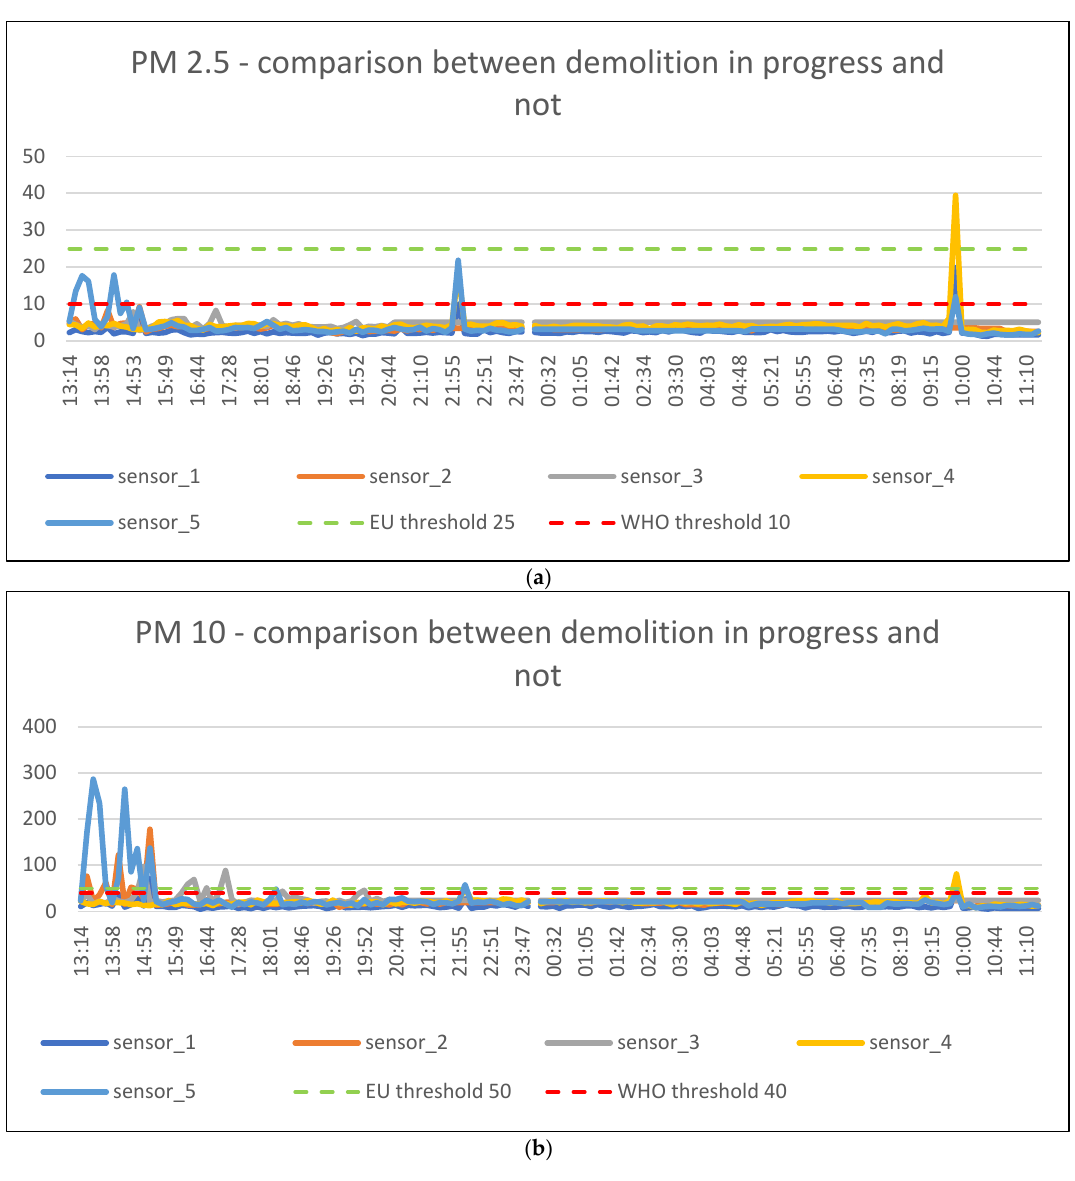
Figure 12. Result of the measurements of PM 2.5 ( a ) and PM 10 ( b ) at a standstill.